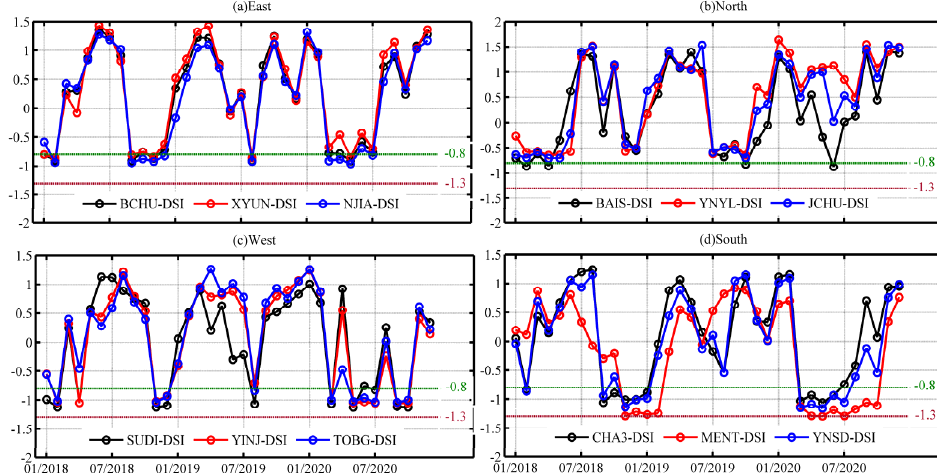
Figure 9. CORS-DSI in different sub-study areas.